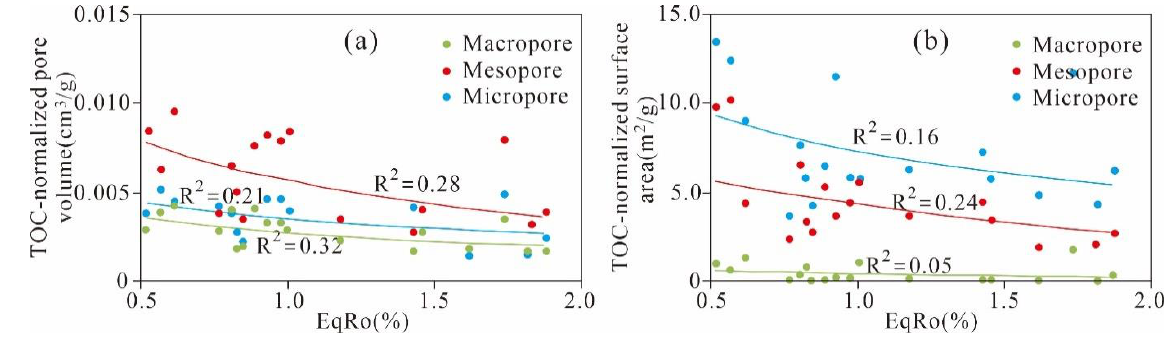
Figure 14. Thermal maturity (EqRo) versus the ( a ) TOC-normalized PV and ( b ) SA of the micropores, mesopores, and macropores.